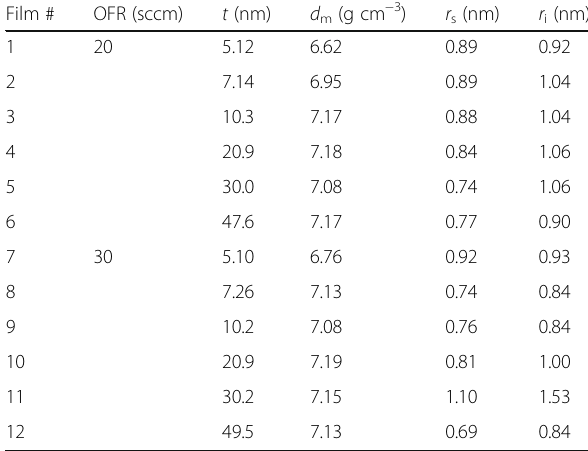
Table 1 Thickness ( t ), mass density ( d m ), and surface and interface roughness ( r s and r i , respectively) for a -ITO films determined by XRR